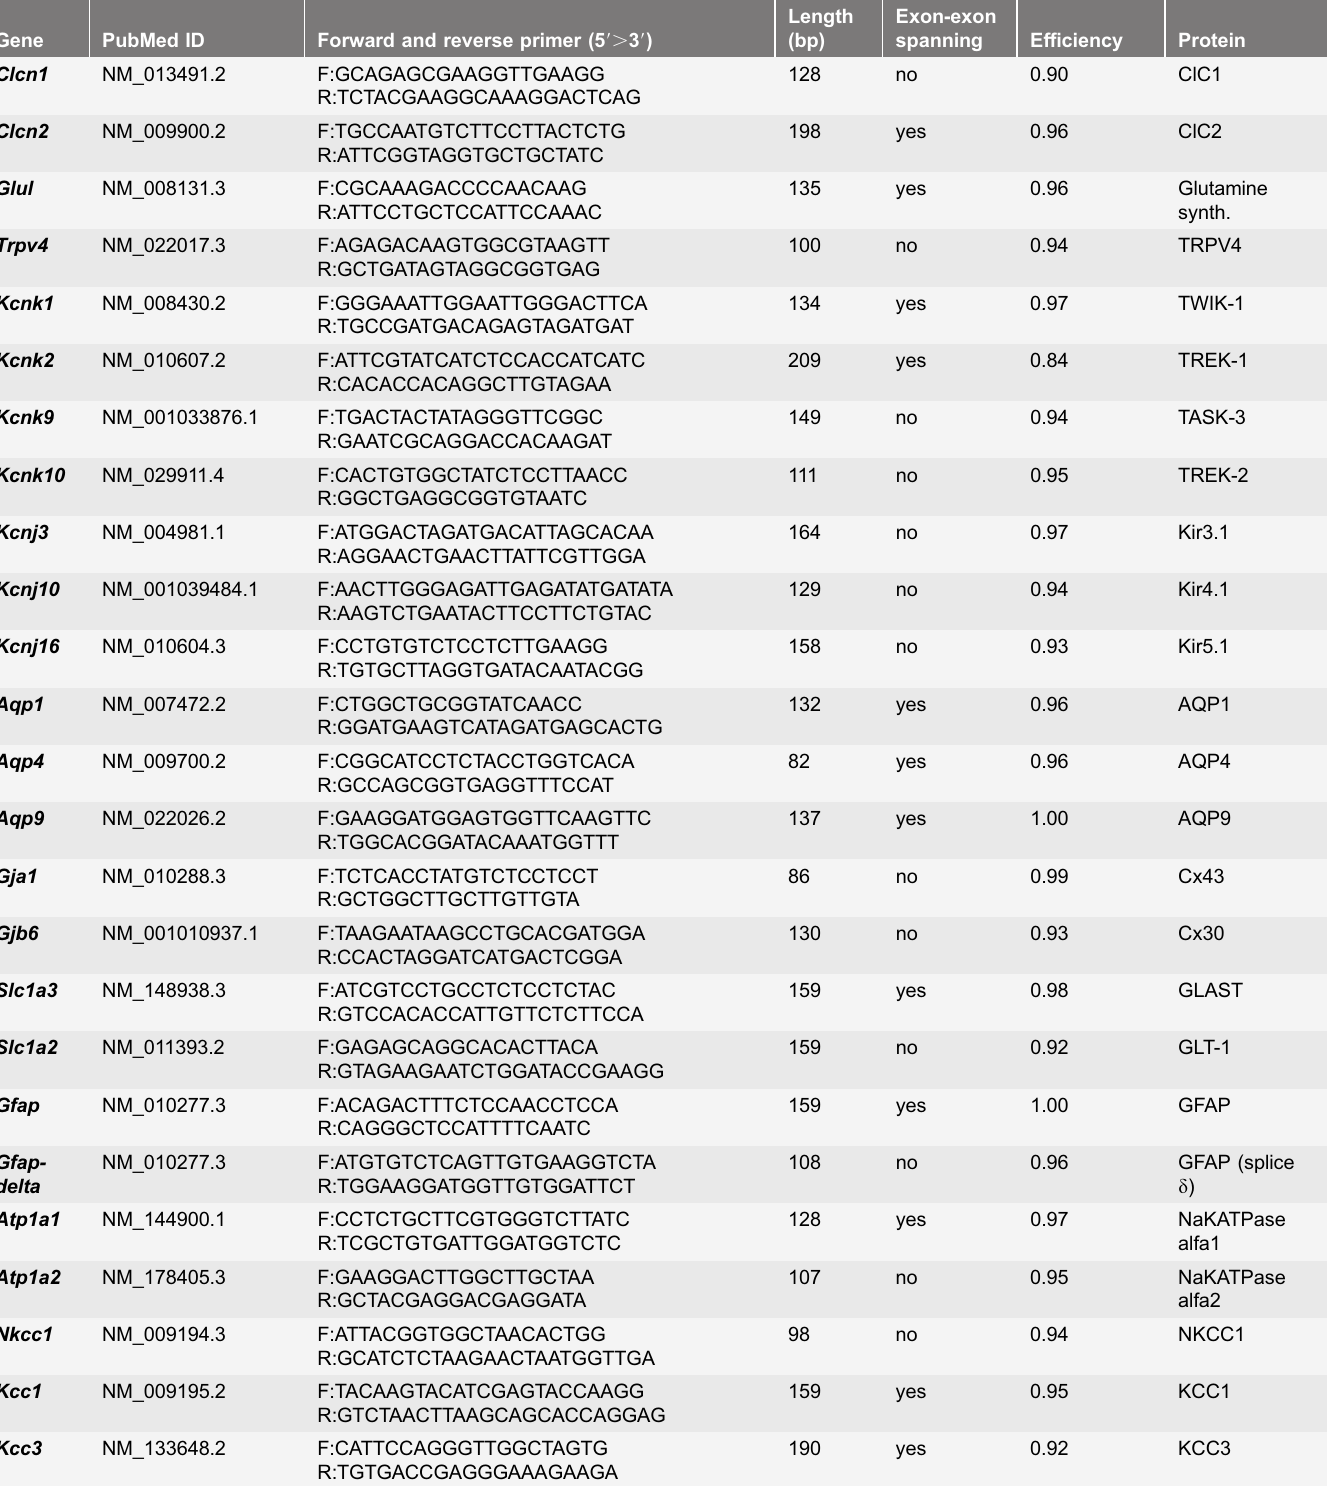
Table 1. Sequences of primers used for